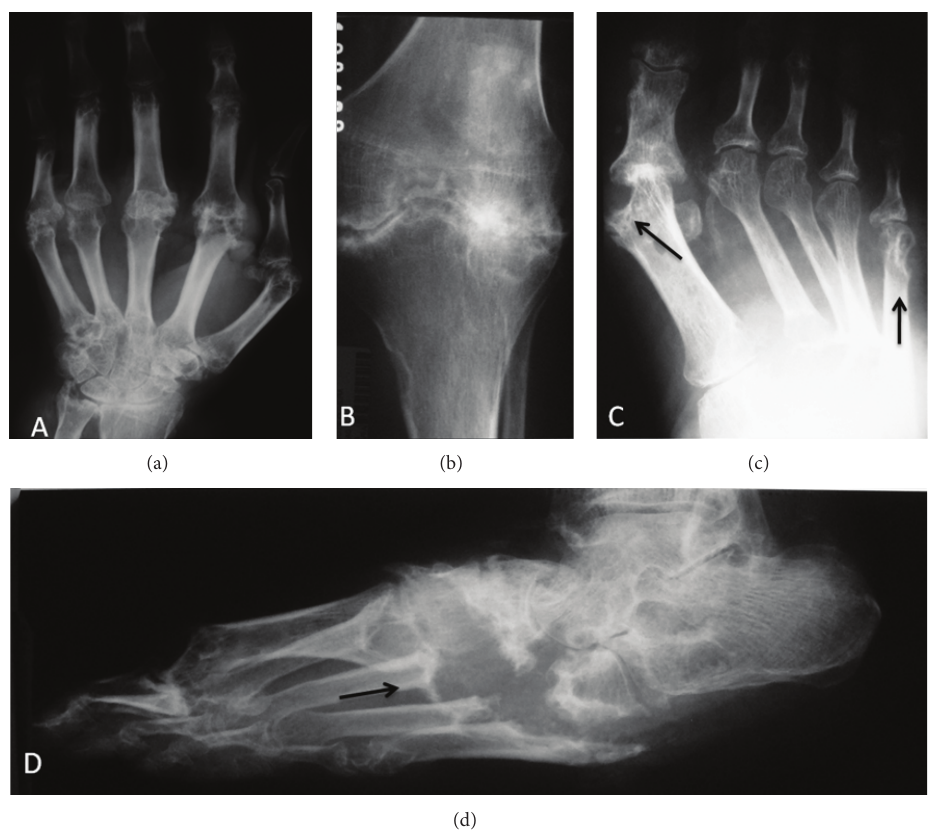
Figure 2: Radiographs of hand (a), knee (b), foot (c), and ankle (d) showing severe destructive changes secondary to tophaceous gout with erosion, soft tissue swelling (tophi), articular space narrowing, and proliferative bone abnormalities. Note the well-defined extra-articular large erosions with overhanging margin and surrounding bone eburnation (arrows). The uniform joint space narrowing with normal bone density in knee and wrist is typical of late gout